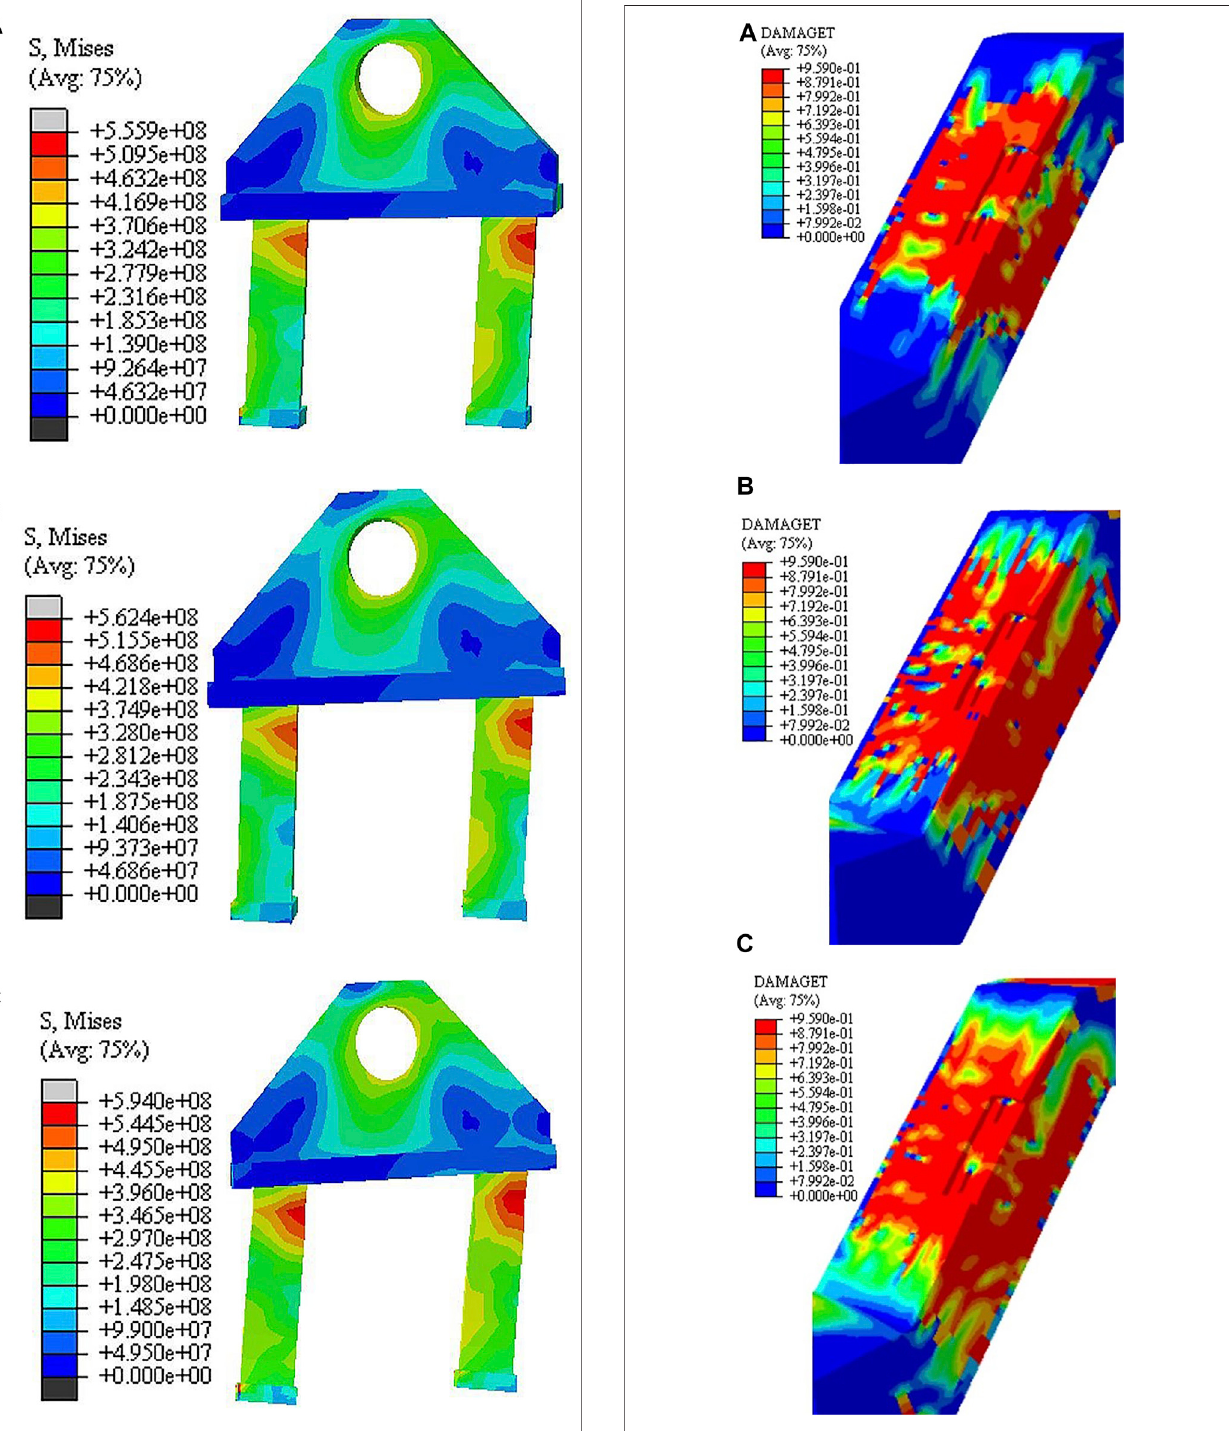
Frontiers in Materials |